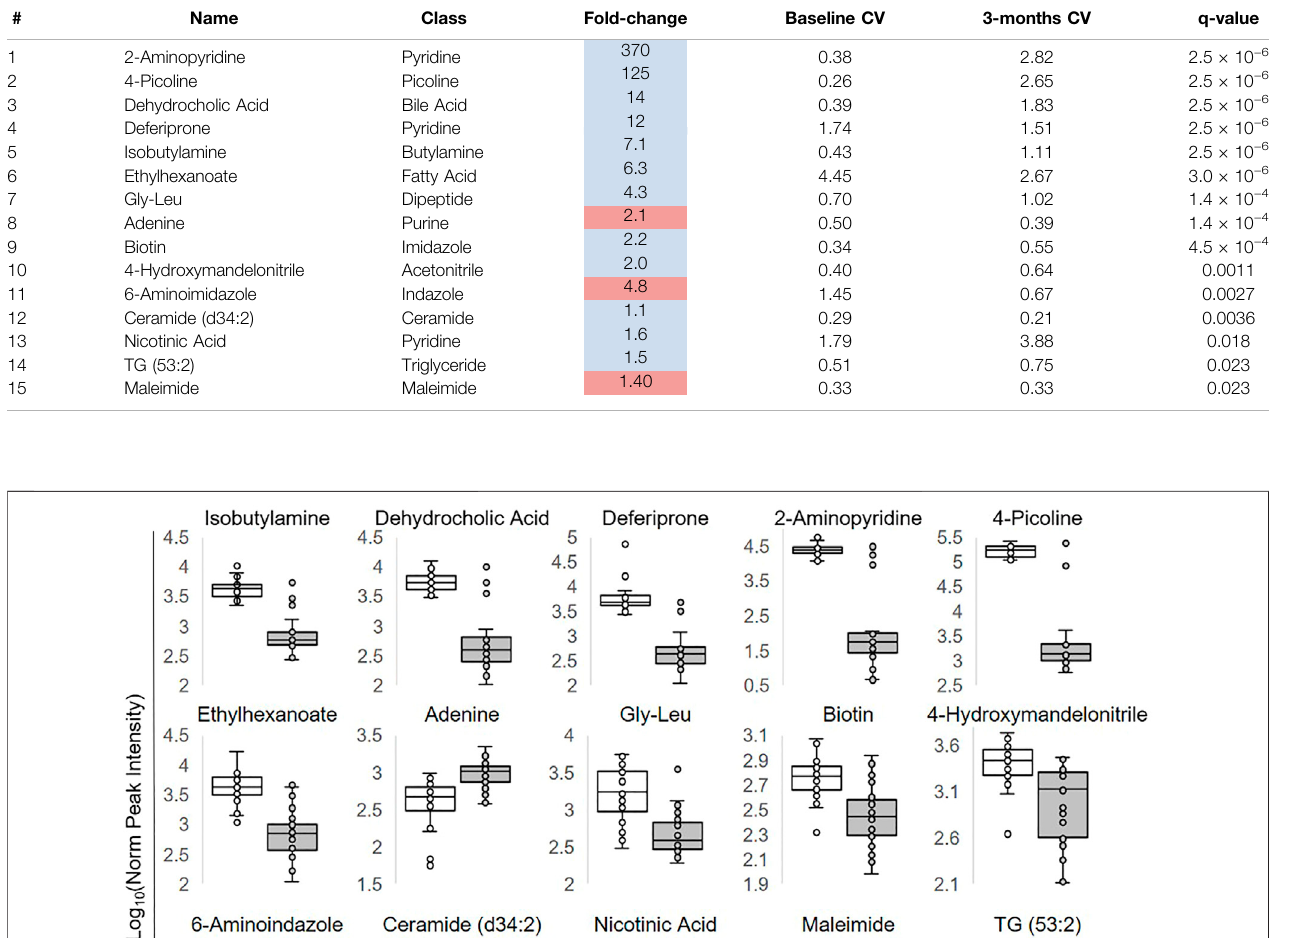
TABLE2| Plasmametabolitesalteredfollowing3-monthsofMTXtherapy.Thetableofmetabolitesareidenti fi edbynumberfromthevolcanoplotin Figure2 .Themetabolite name, chemical class, fold-change color coded based on whether the metabolite increased (red) or decrease (blue), the coef fi cient of variation (CV) for the metabolite at the baseline and 3-months timepoint, and the q-value are provided.